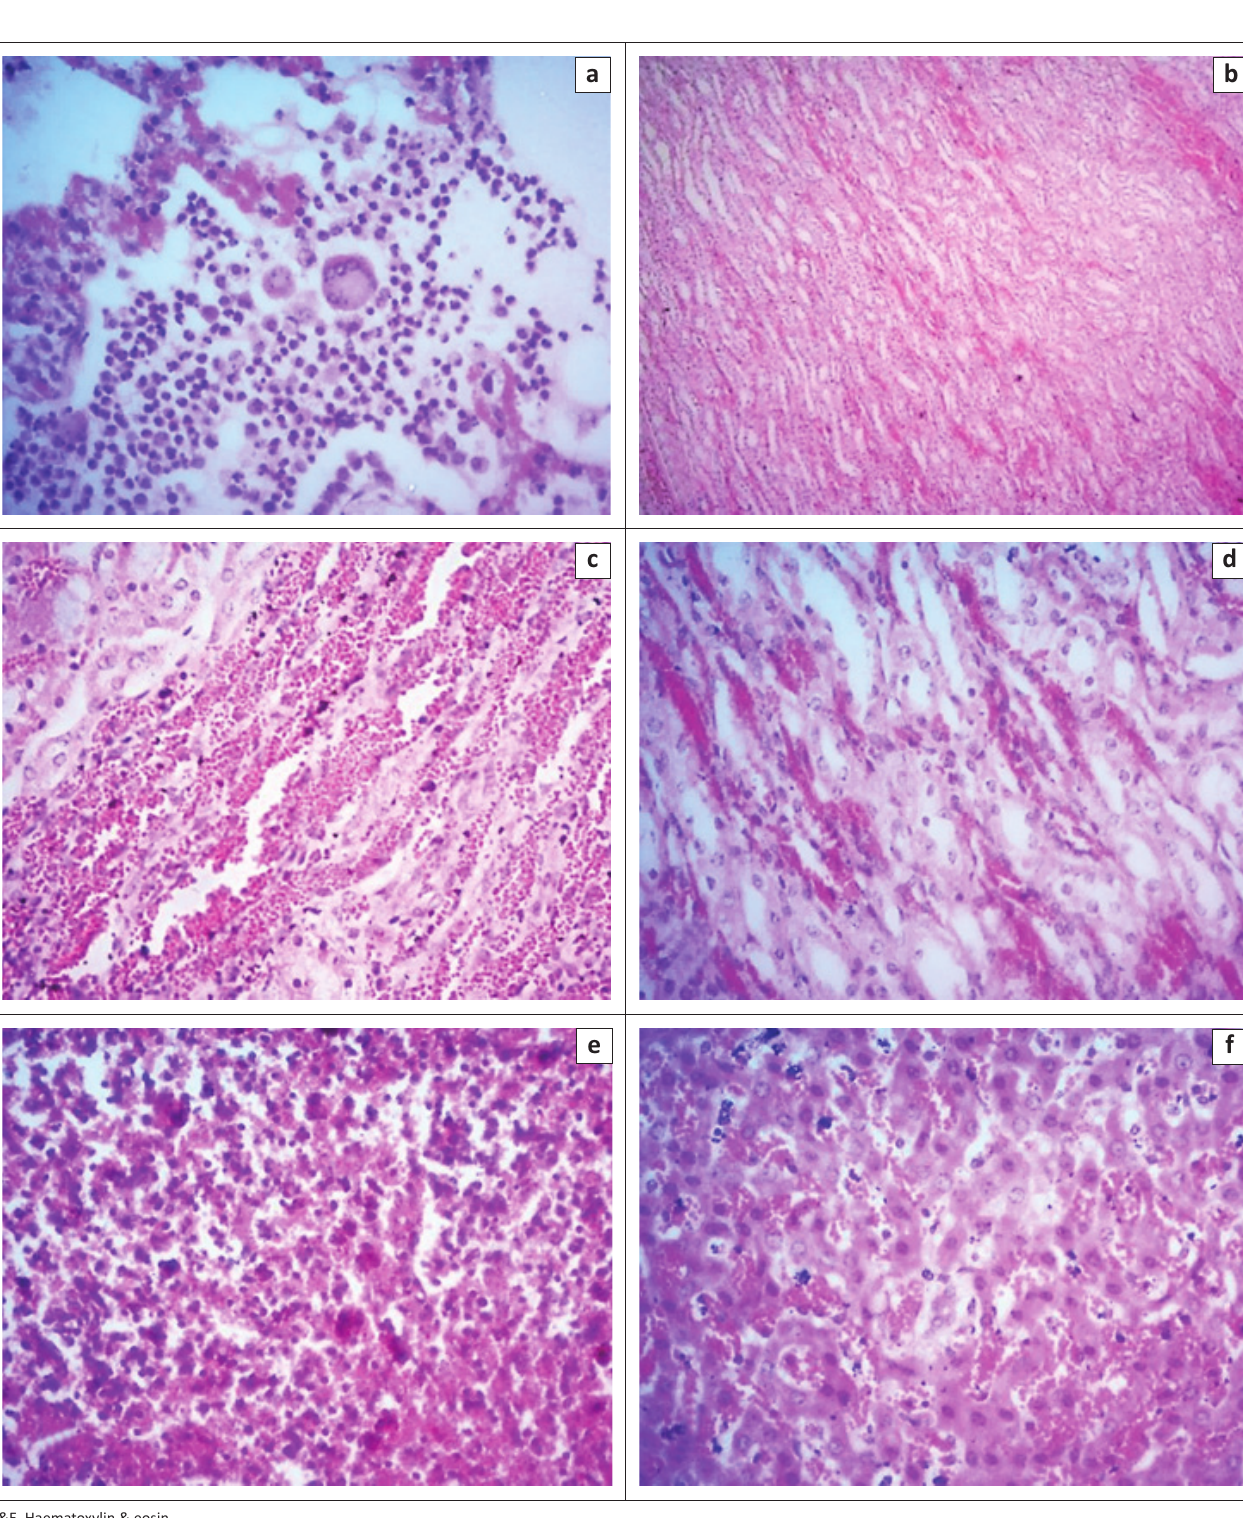
FIGURE 2: Histopathological findings of peste des petits ruminants –infected Black Bengal goats showed haemorrhage and mononuclear infiltration. (a) Peste des petits ruminants –infected lungs showed clumps of large mononuclear and multinucleated cells within the alveoli (H&E stain, 250×). (b) Kidney showed haemorrhage in the tubular area (H&E stain; 62.5×). (c) and (d) Kidneys showed severe haemorrhages and congestion with haemosiderosis (H&E stain, 250×). (e) Haemosiderosis with severe congestion in the spleen (H&E stain, 250×). (f) Congestion with stagnant of bile pigments in the liver (H&E stain, blood parameters such as ESR (Figure 3d) and absolute monocytes, eosinophils and basophils counts (Figure 3g) remained comparable between PPR-infected and healthy goats. Collectively, natural PPR infection in goats induced severe anaemia and leucocytosis.